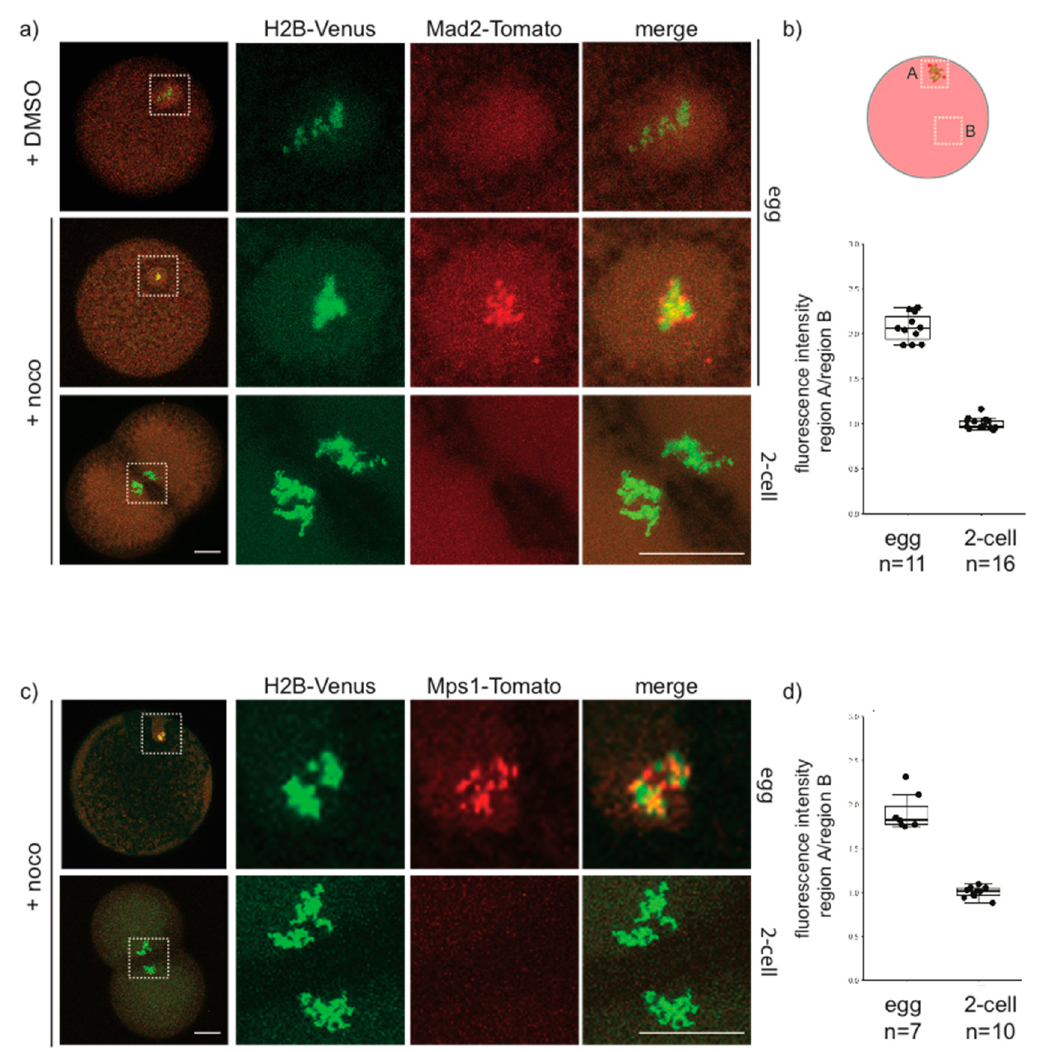
Figure 7. Mad2 and Mps1 are not recruited to unattached kinetochores in 2-cell P. mammillata embryos. ( a ) Representative images of live eggs (top, middle rows) and 2-cell embryos (bottom row) expressing histone H2B-Venus and Mad2-Tomato. ( b ) Ratio of Mad2-Tomato fluorescence intensity in chromosome region (A) and cytoplasm (B) in nocodazole-treated eggs and 2-cell embryos ( c ) Representative images of live eggs (top) and 2-cell embryos (bottom) expressing histone H2-Venus and Mps1-Tomato. ( d ) Ratio of Mps1-Tomato fluorescence intensity in chromosome region (A) and cytoplasm (B) in nocodazole-treated eggs and 2-cell embryos. White squares in (a) and (c) indicate chromatin-containing regions enlarged (5×) on the right images. Scale bar = 30 µm.